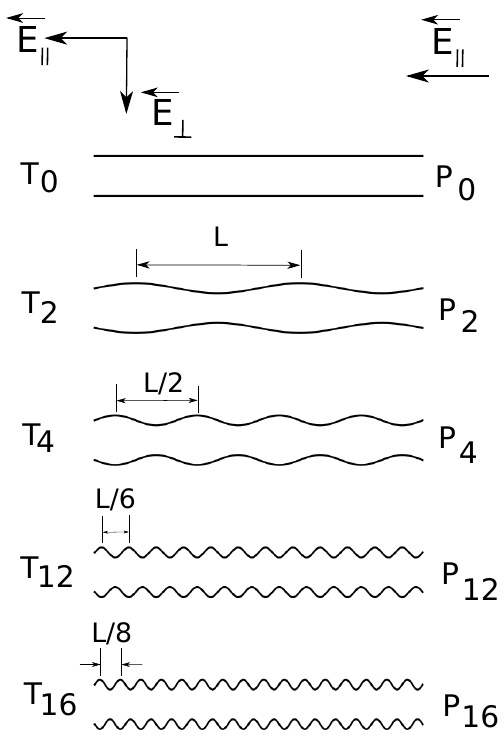
Figure 1. Cross-section schematic illustration (from top to bottom) of constant radius ( 6 σ ) and variable diameter straight cylinders of increasing surface undulations. The depth of surface undulations is constant, 25% of the cylinder radius. P of straight cylinders and parallel applied electric fields ⃗ E ∥ , T straight cylinders and both parallel and transverse applied fields ⃗ E || + ⃗ E ⊥ , etc